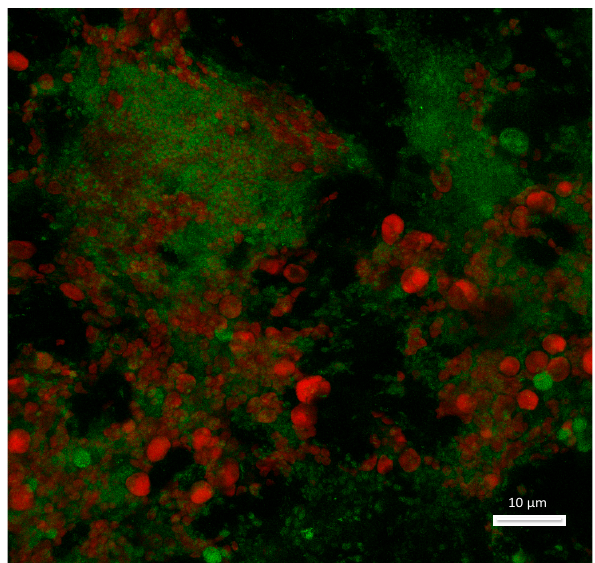
Figure 1. Confocal laser scanning microscopy (CLSM) imaging of the biofilm thrived on the granite surface. The red is the autofluorescence from the chlorophyll of the phototrophs, the green indicates the lipids stained with Lipidtox Green, and the grey is the reflection of the granite stone. Scale bar is 10 µ m. A Leica TCS SP5 X CLSM (Leica Microsystems, Wetzlar, Germany) equipped with a white light